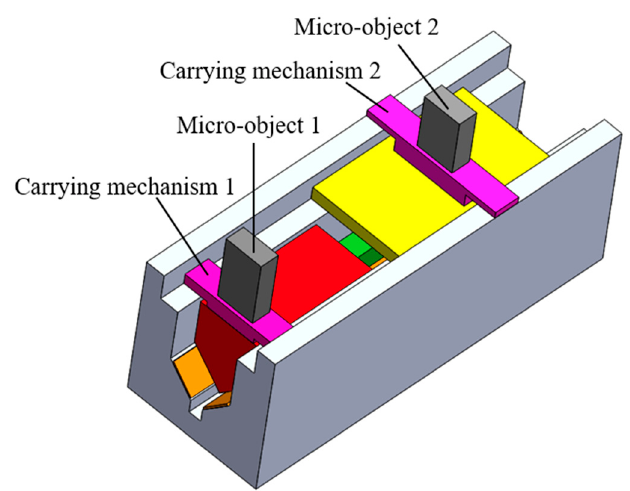
Figure 21. One approach to carry relatively heavy micro-objects.